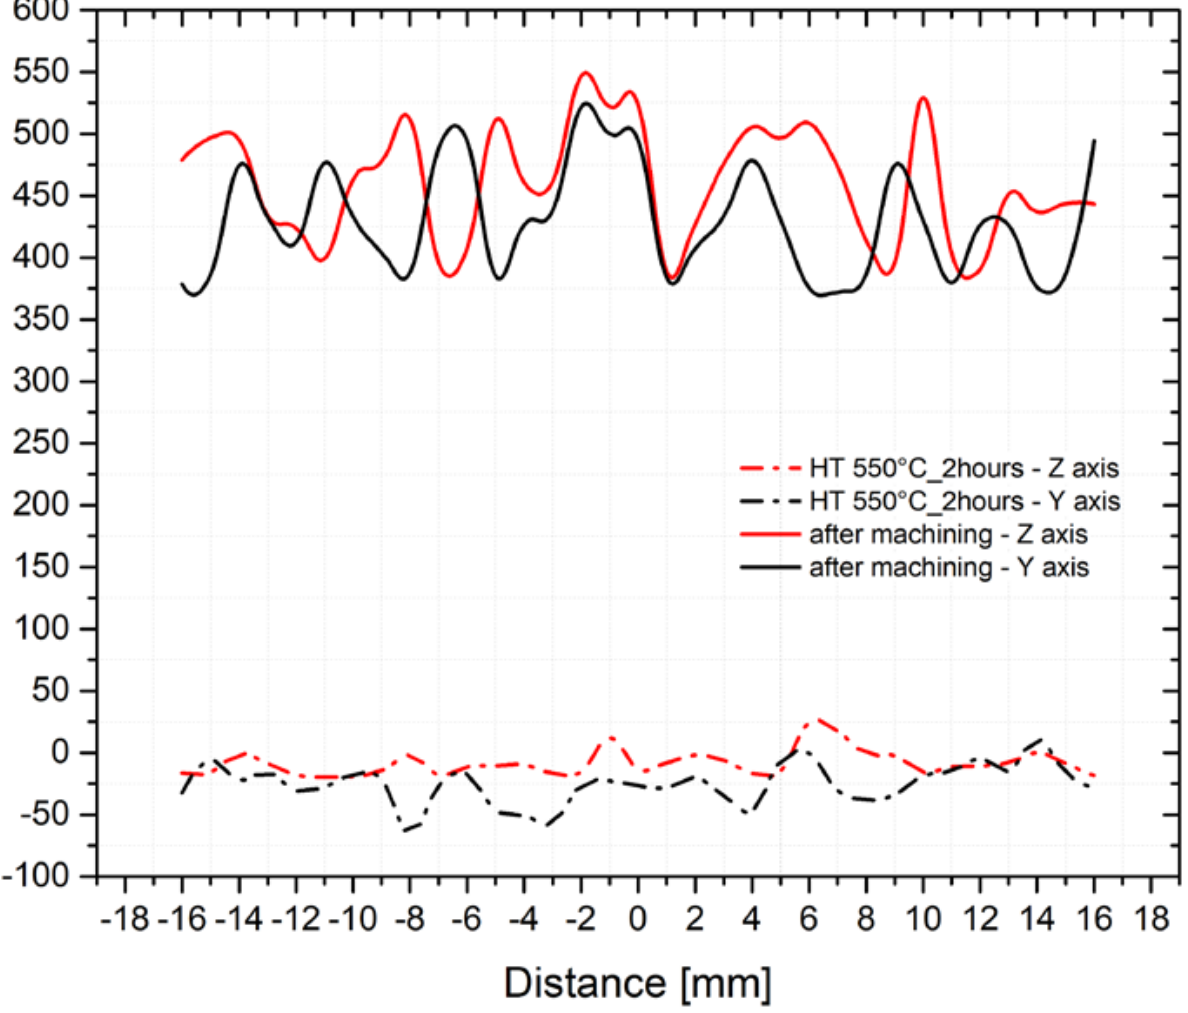
Figure 12. Residual stresses after machining and after HT (Y-axis—black and Z-axis—red).